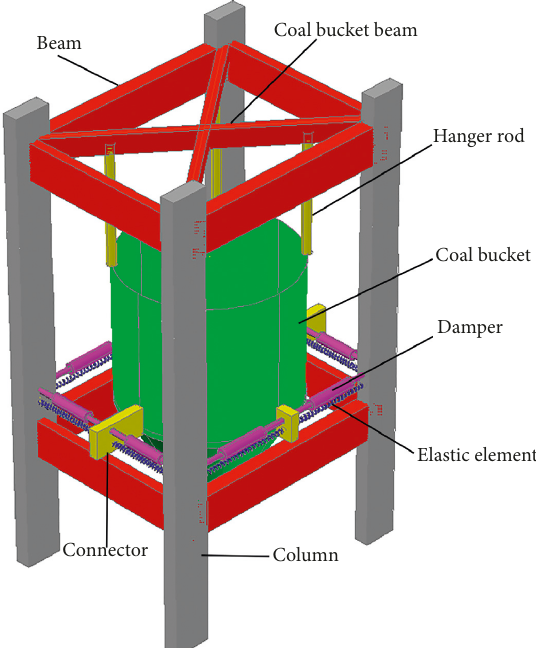
Figure 6: Schematic diagram of a coal bucket